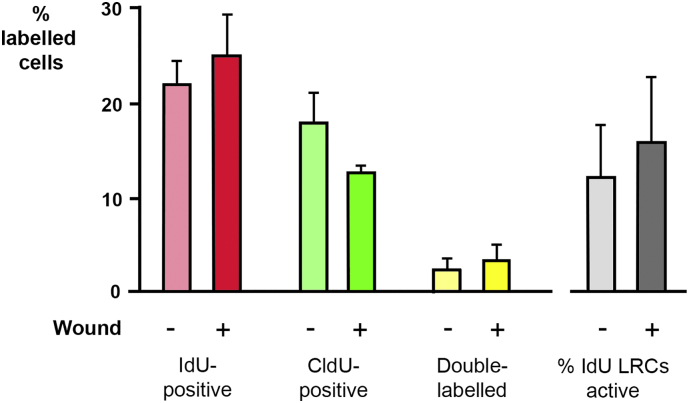
Activity of label-retaining cells in limbal epithelia 0–24 h after corneal wounding in aging mice. Cell proliferation in the limbal epithelia of unwounded and wounded corneas in old mice (1 year). Data are expressed as mean ± SEM of: % IdU-positive cells as a proportion of all cells in limbal epithelium – pink/red), % CldU-positive cells (green), and % of double-labelled cells (yellow) 24 h after wounding. Grey bars show the % of double-labelled cells as a proportion of the IdU-positive cells and represents the percentage of label-retaining stem cells that were dividing in wounded and unwounded eyes. There were no significant differences between wounded and unwounded corneas. (For interpretation of the references to colour in this figure legend, the reader is referred to the web version of this article.)